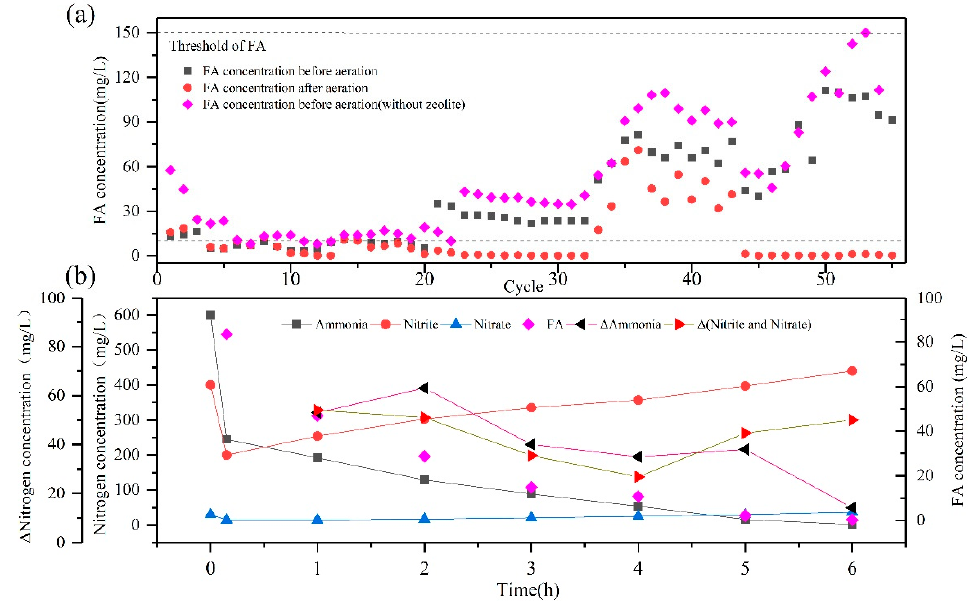
Figure 3. Free ammonia (FA) variations in zeolite sequencing batch reactor: ( a ) The variation of free ammonia concentration during starting period, ( b ) Dynamics of free ammonia and nitrogen in a typical cycle.